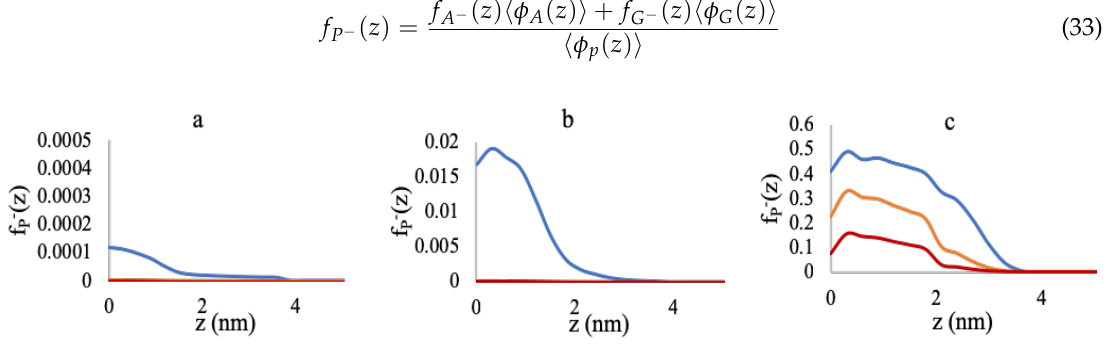
Figure 4. Deprotonated polymer fraction profiles at 3 mM (blue lines), 50 mM (yellow lines), and 180 mM (red lines) MgCl 2 concentrations. ( a ) 0.005 chains/nm 2 , ( b ) 0.05 chains/nm 2 , and ( c ) 0.5 chains/nm 2